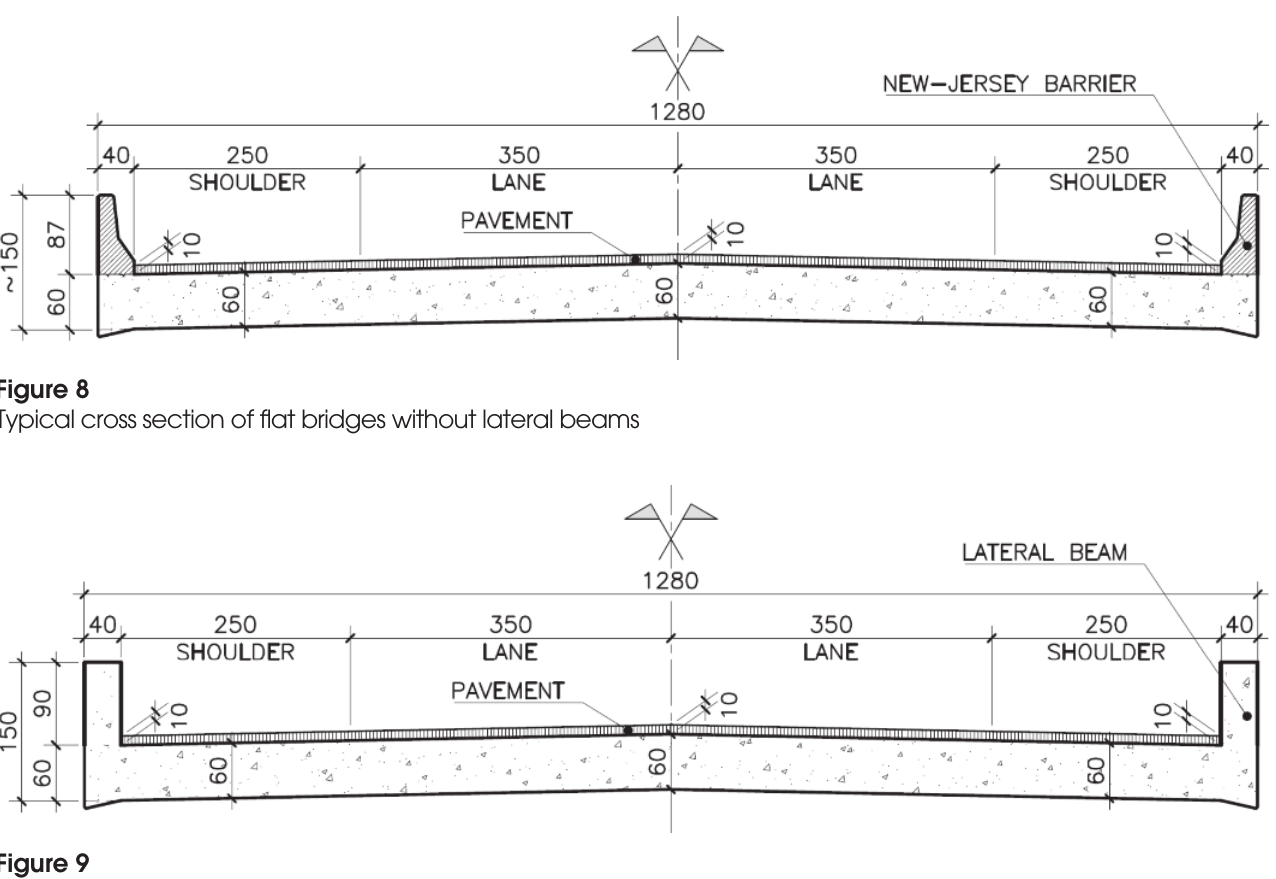
Typical cross section of flat bridges with lateral